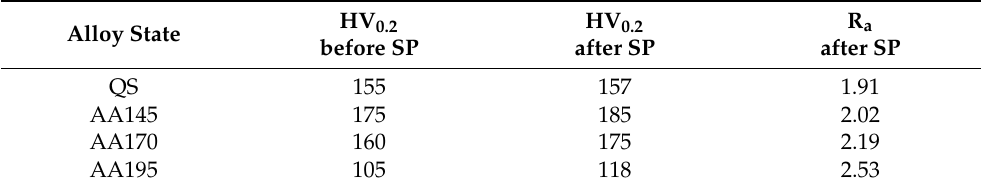
Table 2. Roughness and microhardness parameters of treated